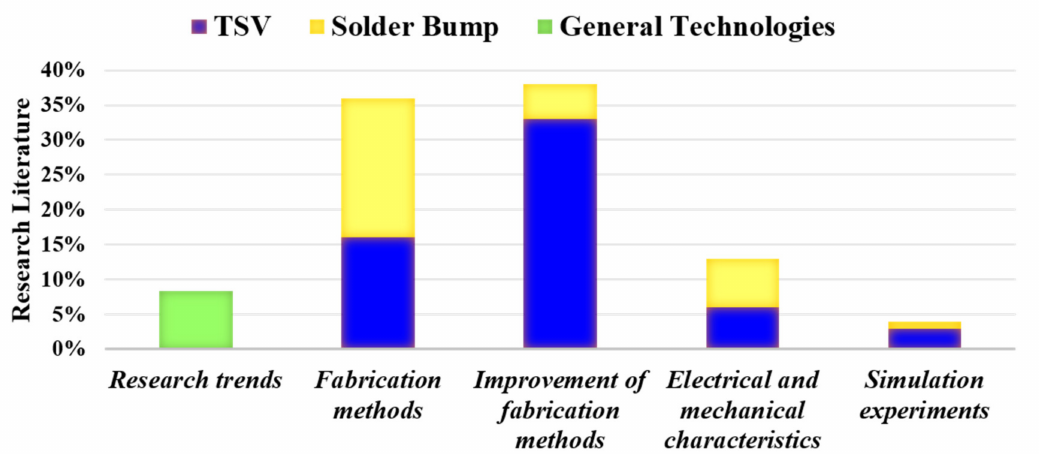
Figure 4. Research topics for TSV and solder bumping focused in the present